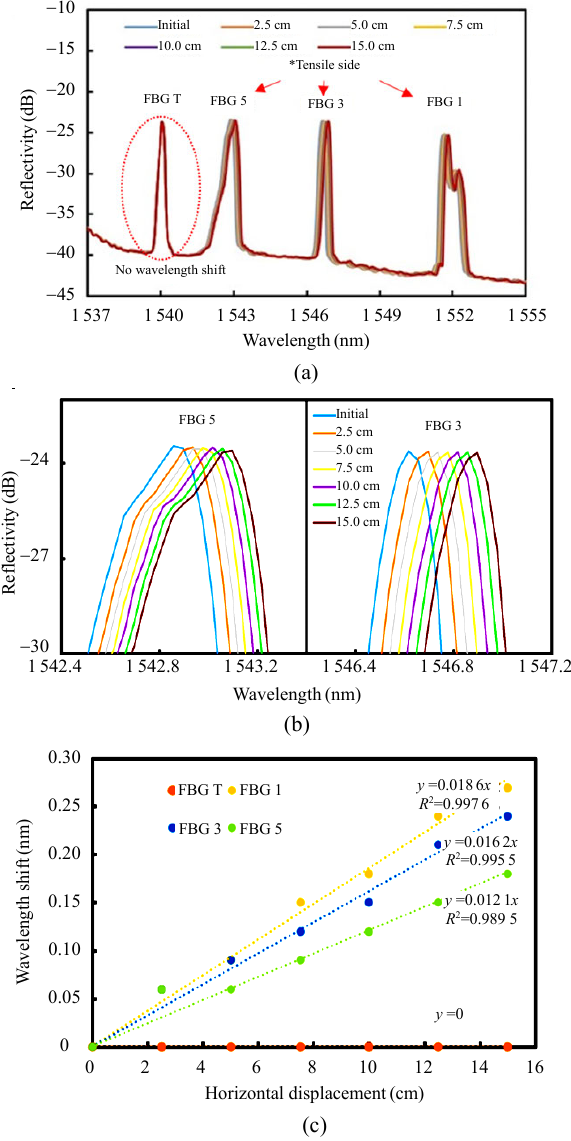
Fig. 9 Illustration of the (a) wavelength spectra of FBG 1, FBG 3, FBG 5, and FBG T at the different horizontal displacements shown (0 cm to 15 cm), (b) magnified wavelength shifts for FBG 5 and FBG 3, and (c) wavelength shifts (nm) of FBG 1, FBG 3, FBG 5, and FBG T during strain measurements over the same horizontal displacement from 0 cm to 15